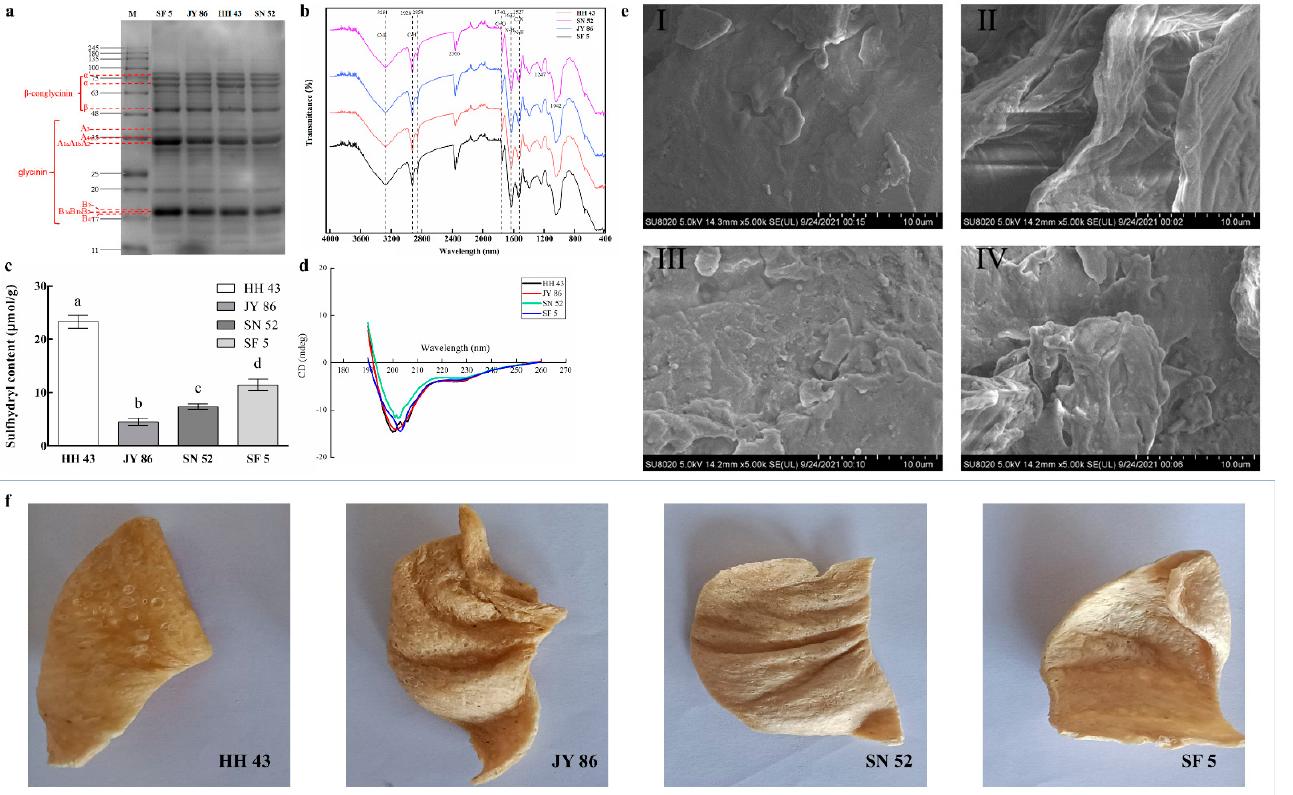
Figure 1. Structural characteristics of four kinds of plant-based meat analogues (PBMs): ( a )